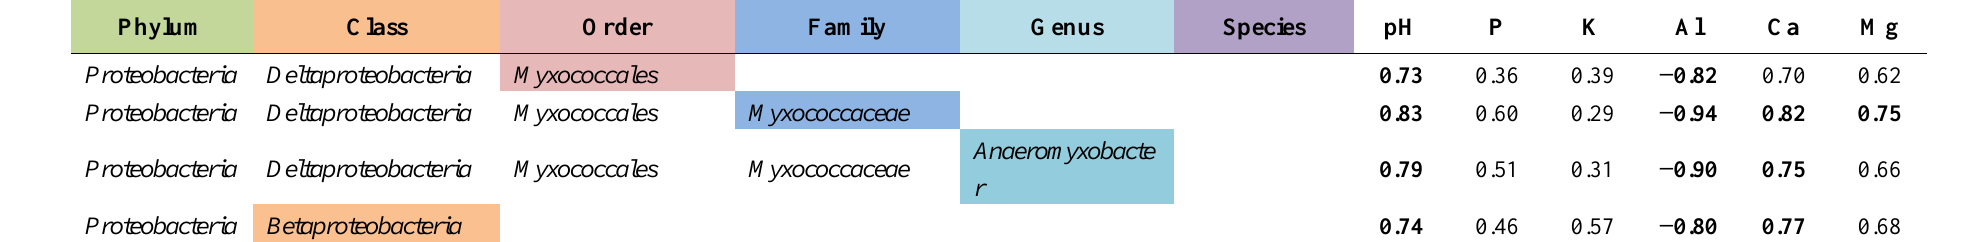
Table 4. Spearman correlations (p ≤ 0.01) of the most correlated organisms with phosphorus (P), potassium (K), aluminum (Al), calcium (Ca) and magnesium (Mg). The correlated microorganisms are within the colorful boxes. The names in gray color represent the correlated microorganism’s related